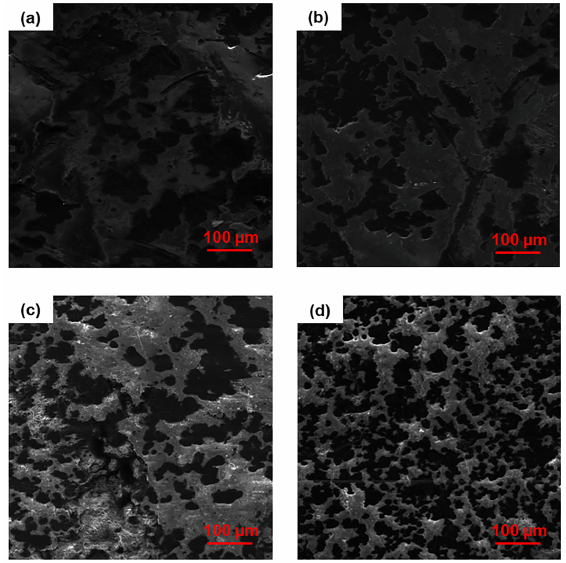
Figure 8. SEM images of non-irradiated ( left ) and irradiated ( right ) samples of ( a , b ) MDPE/MWCNT 5 wt% and ( c , d ) MDPE/GNP 3 MWCNT 1 20 wt% nanocomposites. Due to the formation of entanglements at high nano fi ller contents, we fi nd an increasing number of surface asperities with increasing fi ller concentrations. In particular, we observe a high number of small peaks on the surface of MDPE/GNP specimens. By contrast, the surface morphology of the MDPE/MWCNT 5 wt% and MDPE/GNP 3 MWCNT 1 20 wt% samples is characterized by the presence of large peaks. The reason is a tt ributed to the large aggregates formed due to the weak interaction of the pristine MWCNTs with the MDPE matrix and to the van der Waals forces acting among the MWCNT nanoparticles. A 3D reconstruction of the surface pro fi les was performed to quantify the e ff ect of the radiation exposure at the top surface of the nanocomposite samples. 3D images were obtained with the Mountains Map software, starting from two SEM images acquired at two di ff erent tilt angles (0° and 1°). Results of the 3D surface reconstruction are reported in Figure 9 and Figure 10. A decrease in the height of surface peaks in irradiated nanocomposites is clearly visible on the color-scaled SEM images, which corresponds to an increased surface smoothness. Table 7 presents the R a values of the nanocomposites before and after proton irradiation. Despite the di ff erent nano fi ller concentrations, the MDPE/GNP 3 MWCNT 1 20 wt% and MDPE/GNP 15 wt% non-irradiated nanocomposites show similar values of the R a . This result is explained by the presence of both GNP and MWCNT nano fi llers in the hybrid system, where the graphene nanoplatelets prevent the aggregation of nanotubes by physically hindering the process due to their large surface area [45]. All nanocomposites show a signi fi cant decrease of R a upon exposure to proton radiation, with the largest variation observed in the MDPE/GNP 15 wt% (76.5%). This result con fi rms the cleavage e ff ect of irradiation on the edges of the GNPs and subsequent surface erosion.